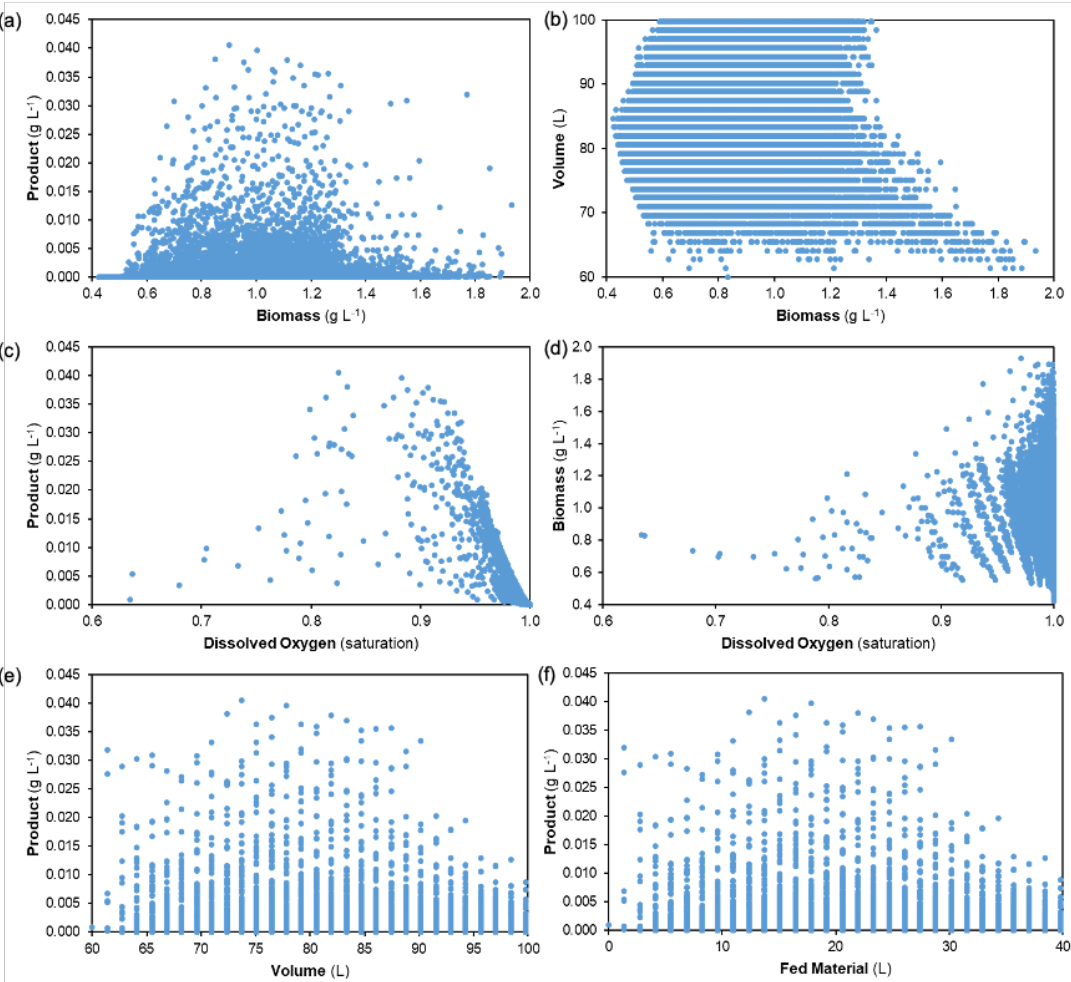
Figure 9. Trade-offs at the end of batch duration for different reactor feedrate profiles ( t f = 96 h): ( a ) product vs. biomass concentrations, ( b ) culture volume vs. biomass concentration, ( c ) product vs. dissolved oxygen concentrations, ( d ) biomass vs. dissolved oxygen concentrations, ( e ) product concentration vs. culture volume, and ( f ) product concentration vs. amount of fed material.